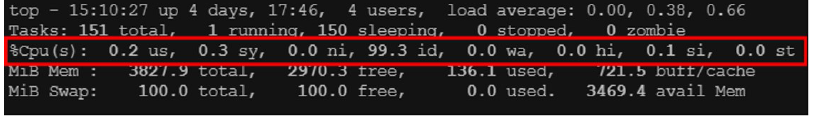
Figure 7. The system information of SCADA server in status of accessing sensor.